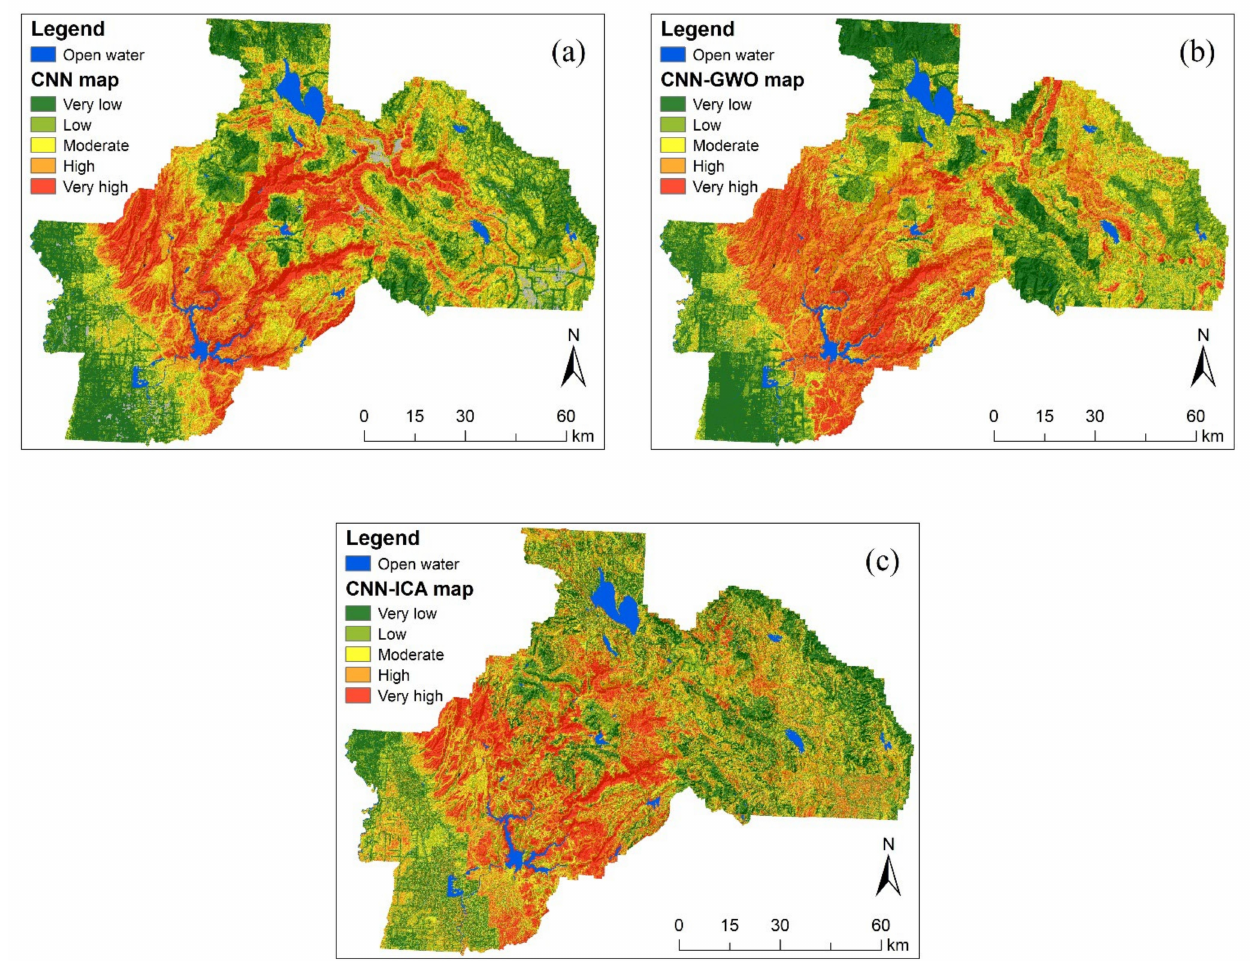
Figure 7. Wildfire susceptibility maps generated using 2016–2020 wildfire inventory and the ( a ) CNN, ( b ) CNN-GWO, and ( c ) CNN-ICA